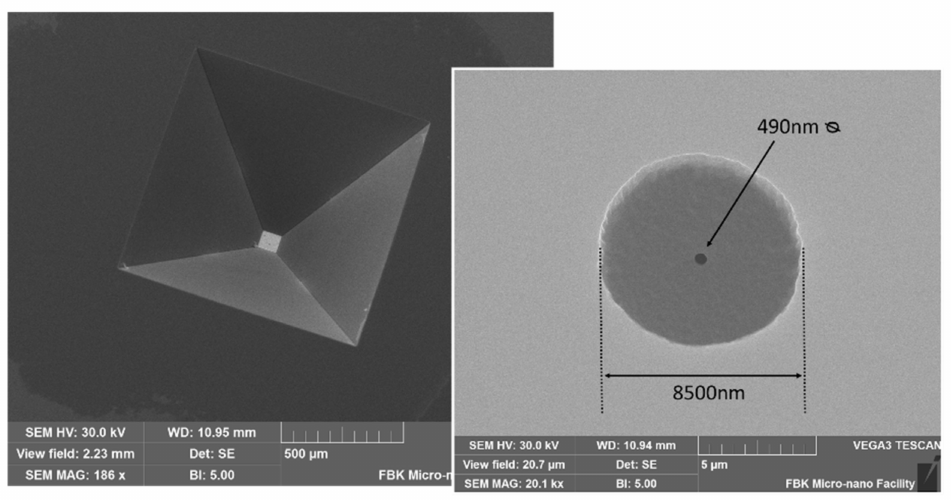
Figure 9. SEM image of a membrane from the chip backside ( left ) with detail of the sub-membrane and orifice ( right ).